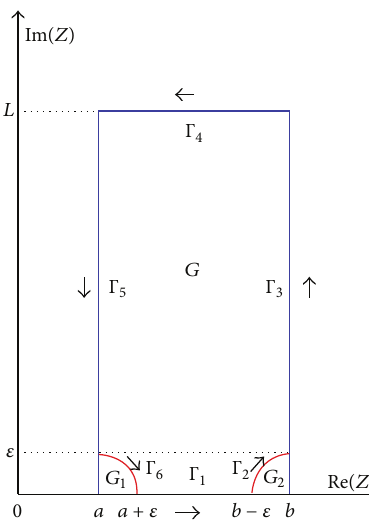
Figure 1: Illustration of the integration paths for the integrand (𝑥 − 𝑎) 𝛼 (𝑏 − 𝑥) 𝛽 𝑓(𝑥)𝑒 𝑖𝜔𝑥